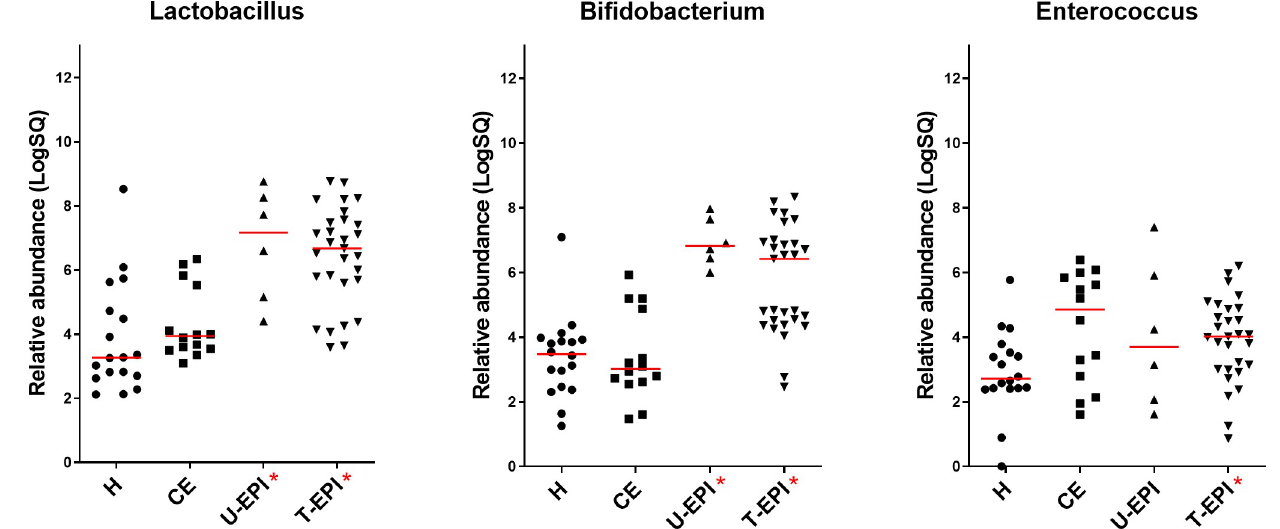
Fig 4. Abundance of specific lactate-producing bacterial groups in healthy and diseased dogs. Abbreviations as in Fig 1.